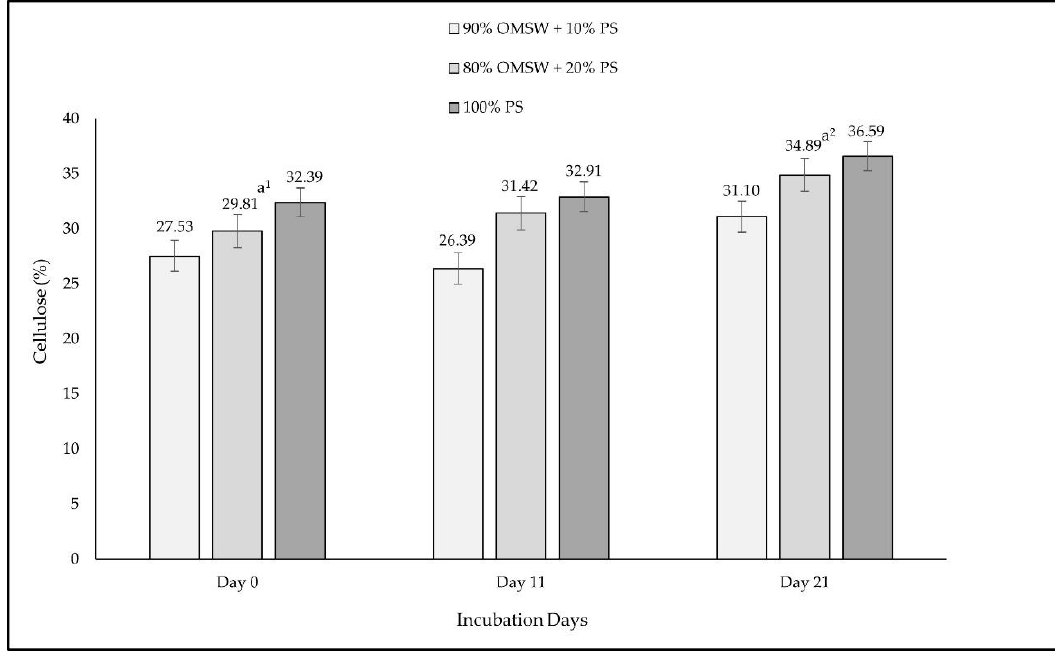
Figure 6. Evaluation of Cellulose content for PS and its mixtures with OMSW. Statistical analysis was performed for each substrate individually between Day 0 and Day 21. Different superscripts between the same letters indicate statistical significance ( p ≤ 0.05).